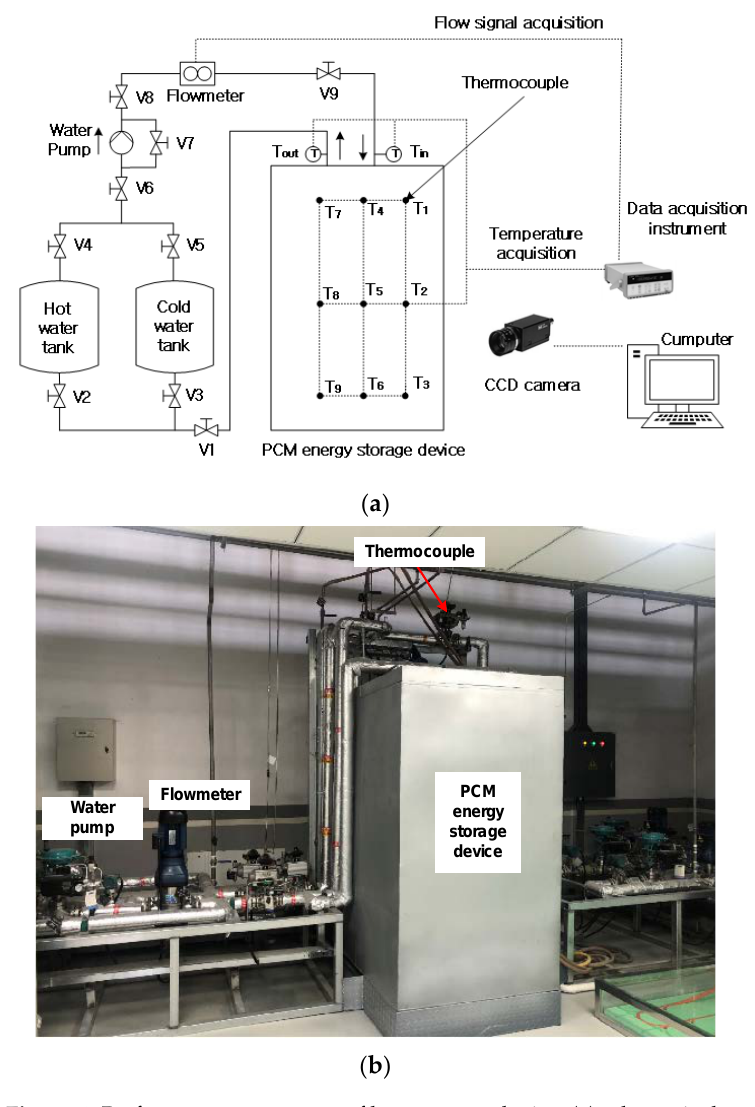
Figure 4. Performance test system of heat storage device: ( a ) schematic the experimental system and ( b ) the full view.